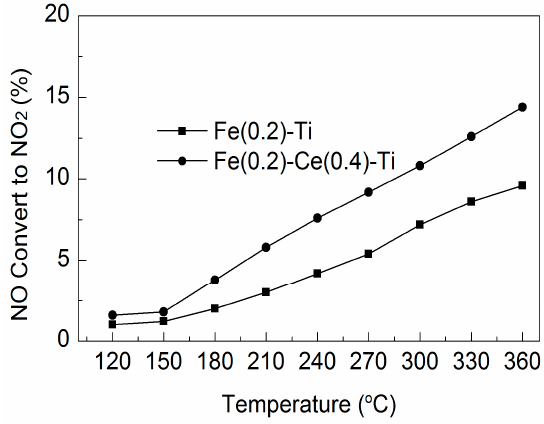
Figure 4. Oxidation activity of NO to NO 2 by O 2 on Fe(0.2)–Ti and Fe(0.2)–Ce(0.4)–Ti catalysts. Reaction conditions: [NO] = 500 ppm, [O 2 ] = 5 vol. %, N 2 balance, and GHSV = 90,000 h − 1 .